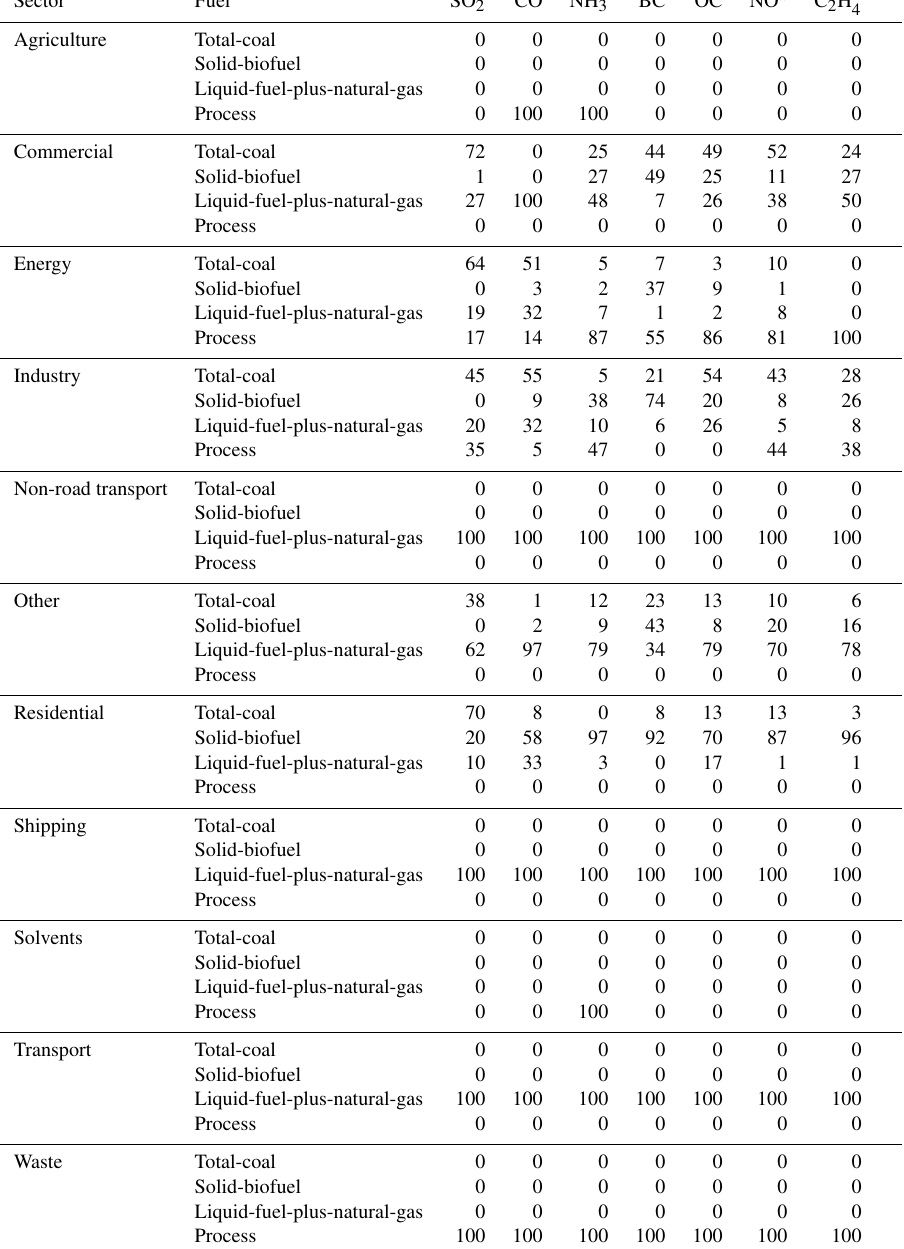
Table A1. Percentage of base-year (2014) CEDS emissions from different fuel consumption versus process sources (broken down by sector, aggregated